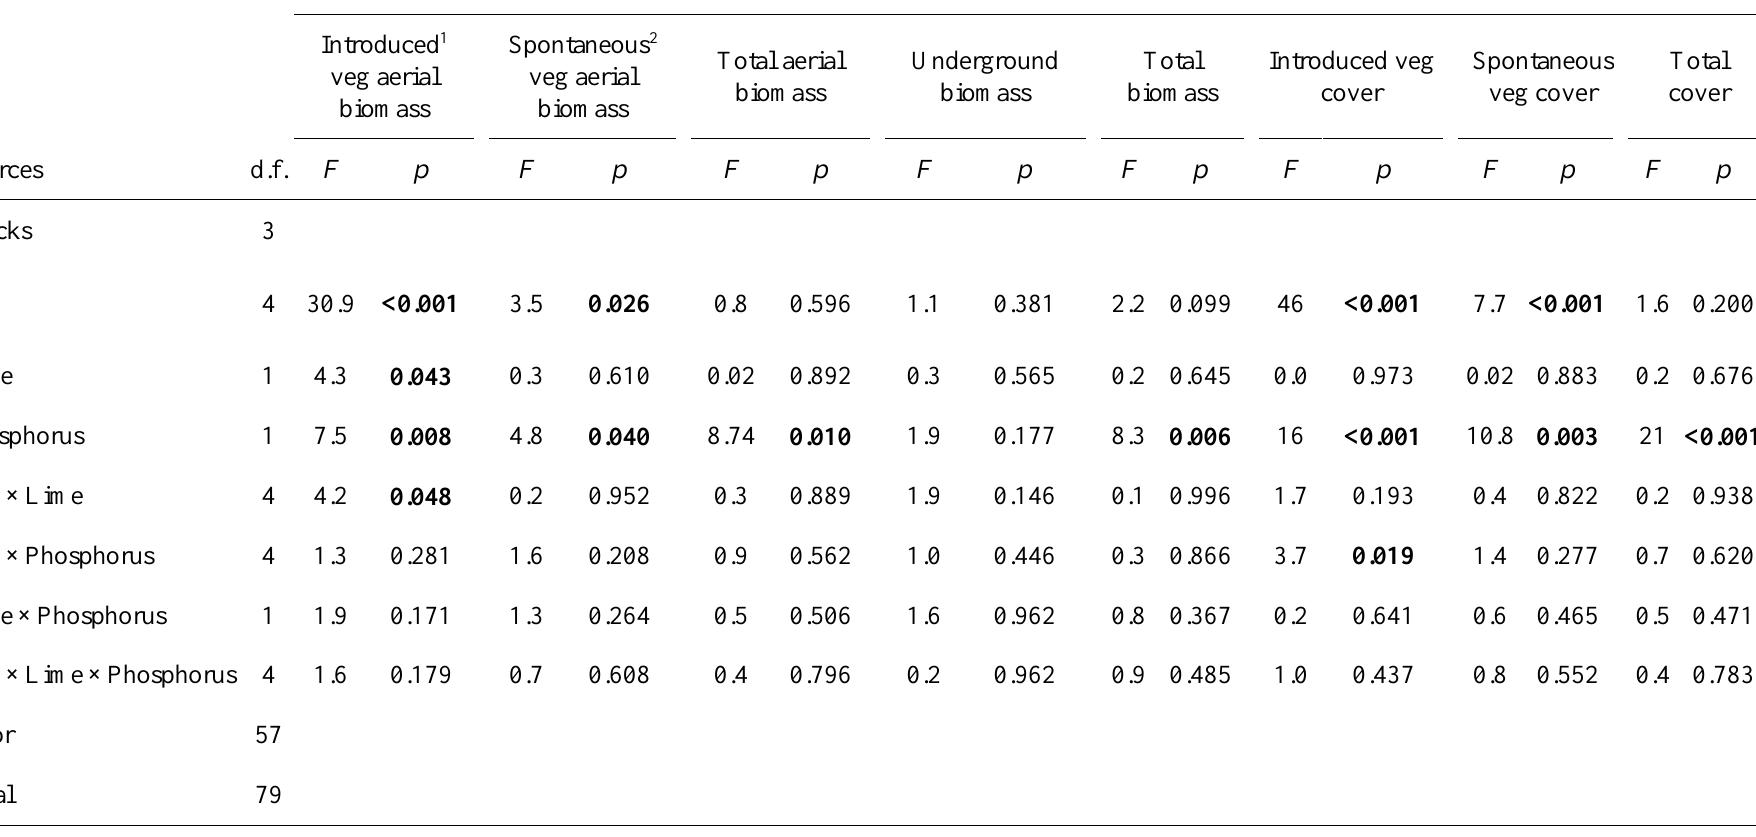
Table A2. Results of 3-way ANOVA testing for soil amendments and introduced plant material effects on biomass in the field experiment. Significant p values are in bold type ( n = 80). Veg = the types of plant material